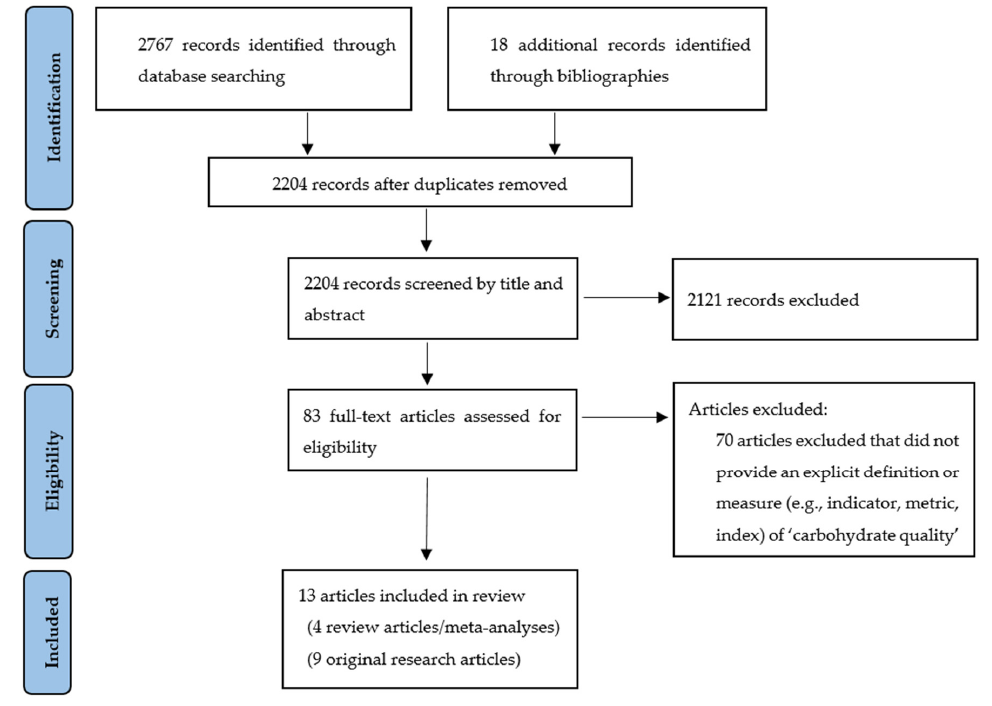
Figure 1. Flow Diagram Describing Article Selection